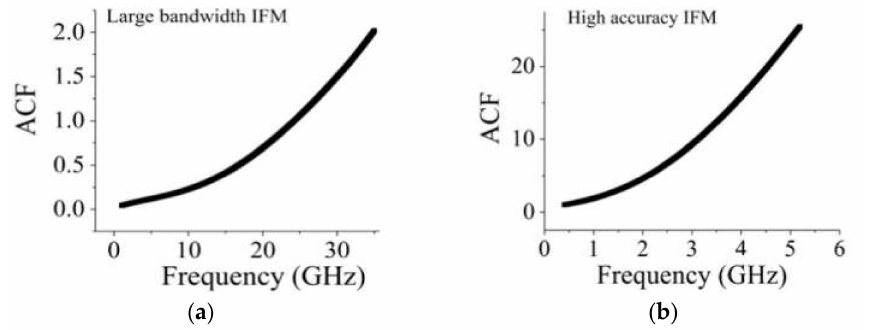
Figure 19. The reference ACF versus the input signal’s frequency: ( a ) for a 0.5–35 GHz frequency range IFM system; ( b ) for a 0.1–5 GHz frequency range IFM system respectively (Adapted with permission from Ref [32]. Copyright 2017,